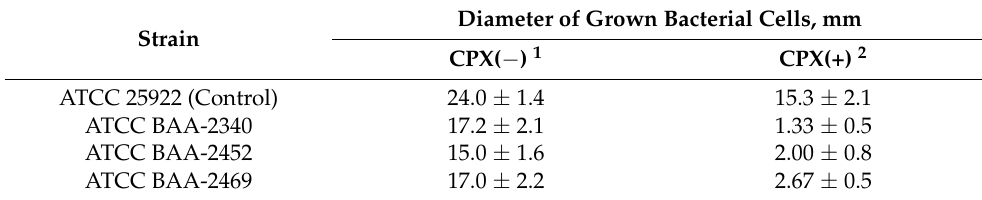
Figure 1. Confirmation of Mcr-1 expression in E. coli ATCC 25922. ( a ) Confirmation of mcr-1 expression from the related plasmid. PCR amplification using pQE-60-specific primer sets was performed for KS7001 (pQE-60, lane 1) and KS8001 (pQE-60- mcr-1 , lane 2), which overproduced a His-tagged Mcr-1 protein [45], on 1% agarose gel wis shown. M and asterisk (*) indicate the DNA size marker (GeneRuler 1kb Plus DNA ladder; Thermo Scientific, MA, USA) and a non-specific PCR product, respectively. ( b ) Detection of Mcr-1 protein. Mcr-1 protein from KS8001 was detected by Western blotting with an Anti-His tag Antibody (Sino Biological, Wayne, PA, USA). Image acquisition and quantitative analysis were performed by using ChemiDoc TM MP Imaging System (Bio-Rad, Hercules, CA, USA) and Image Lab TM Software (ver 5.2.1; Bio-Rad, Hercules, CA, USA). Table 2. Motility of E. coli strains under CPX